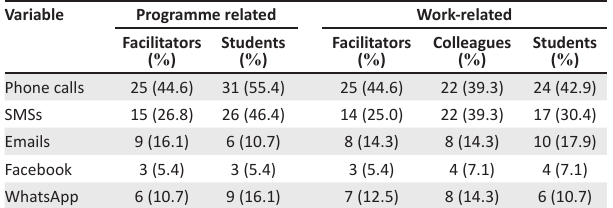
TABLE 2: Mobile phone functionalities used ( N =